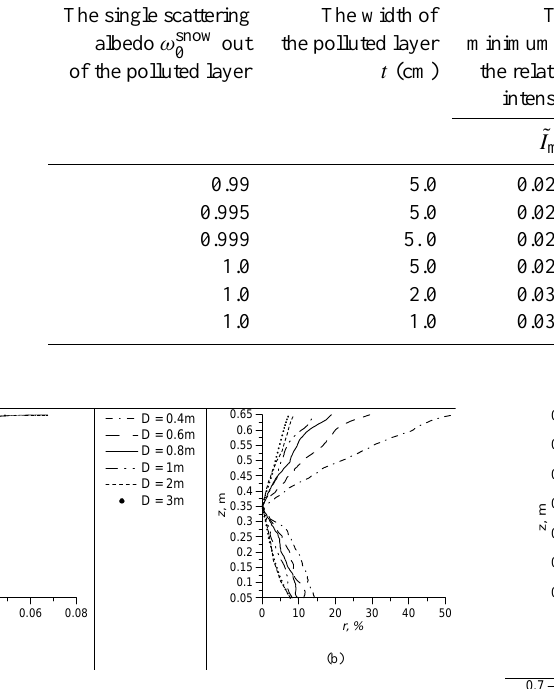
Fig. 14 Fig. 14. Relative intensity ˜ I(z) in the direction (cid:127) ∗∗ (a) and the de- viation r(z) ; (b) on the vertical wall AB of the homogeneous snow- = 0 . 98, the depth pack. The snow single scattering albedo ω snow 0 H = 0 . 7m for, no black film, different widths D .